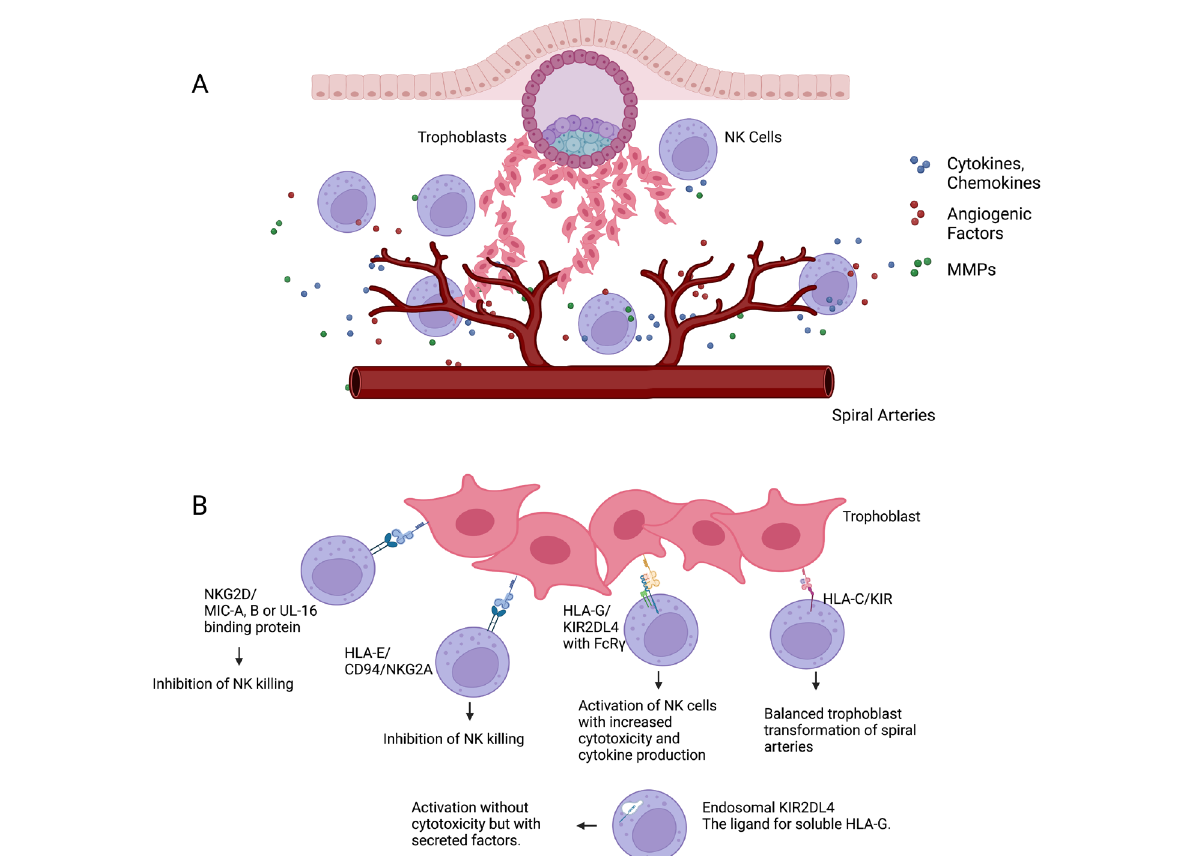
Figure 3. NK cell interactions. A) NK cells in decidua interact with invading trophoblast and secrete various cytokines, chemokines, angiogenic factors, and enzymes for tissue remodeling, such as matrix metalloproteinases (MMPs). NK cells in decidua secrete angiogenic factors (VEGF-C, PGF, ANG1, ANG2), chemokines (CCL1, XCL1, CCL2, CCL3, CCL4), cytokines (IL-15 and IL-18) and MMP-9; B) NK cell receptor interactions with HLA-C, HLA-G, and HLA-E on trophoblasts. HLA-E/CD94/NKG2A interactions lead to inhibition of NK killing. HLA-G/KIR2DL4 with FcRγ leads to activation of NK cells with increased cytotoxicity and cytokine production. HLA-C/KIR interactions allow for a balanced trophoblast transformation of spiral arteries, whereas endosomal KIR2DL4/HLA-G allows for a proinflammatory and proangiogenic response. Additionally, dNK cells interact with trophoblast cells via their NKG2D receptor and MHC class I chain-related (MIC) proteins A and B, or UL-16 binding proteins (ULBPs), inhibiting